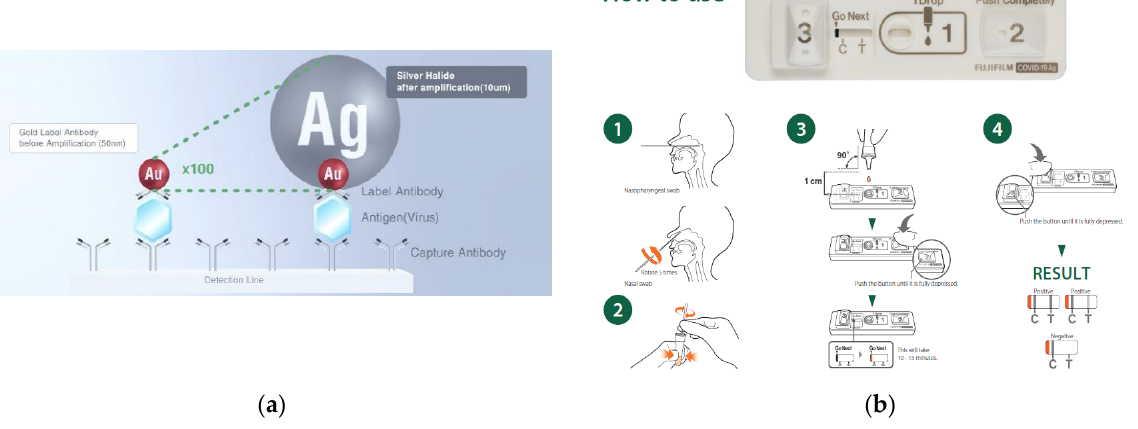
Figure 1. Details of the FUJIFILM COVID-19 Ag test. ( a ) The principle of silver amplification tech- nology: colloidal gold particles are amplified approximately 100 times, increasing the detection sensitivity; ( b ) Instructions for using the FUJIFILM COVID-19 Ag test. Collected specimens were diluted with an extraction buffer in the tube included in the package, and one drop of the sample was added onto the sample well of the FUJIFILM COVID-19 Ag test. Button 2 was pressed imme- diately to release reducing reagents for the silver amplification. After the Go Next indicator mark turned orange (after about 10–15 min), button 3 was pressed to release Ag ions to activate the silver amplification